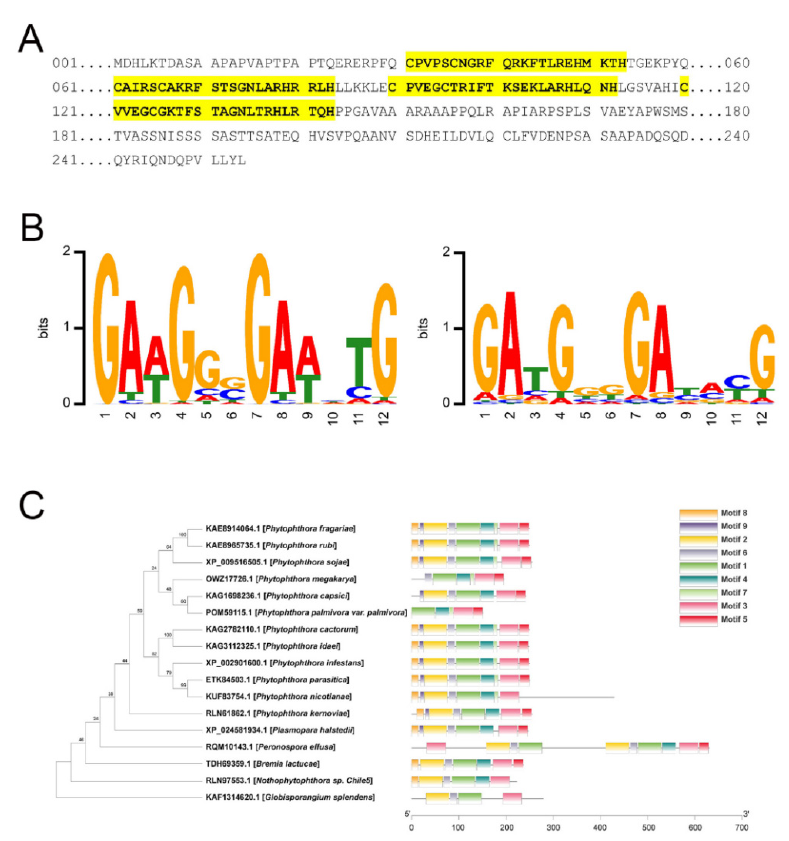
Figure 4. PsCzf3 protein domain analyses. ( A ) Amino acid sequence and putative C 2 H 2 -type zinc finger domains of PsCZF3. Amino acid sequences highlighted in yellow indicate predicted C 2 H 2 - type zinc finger domains. ( B ) Sequence logos for the predicted transcription factor binding site (TFBS) sequences. Left, TFBS analysis based on the webtool “ZFModels” (http://stormo.wustl.edu/ZFModels/ , accessed on 1 April 2014); Right, TFBS prediction based on the webtool “DNA-binding Specificities of Cys2His2 Zinc Finger Proteins” (http://zf.princeton.edu, accessed on 9 September 2010). ( C ) Motif analysis of selected PsCZF3 orthologs across oomycetes. Each motif is represented by a numbered colored box. The length of the protein can be estimated while using the scale at the bottom.